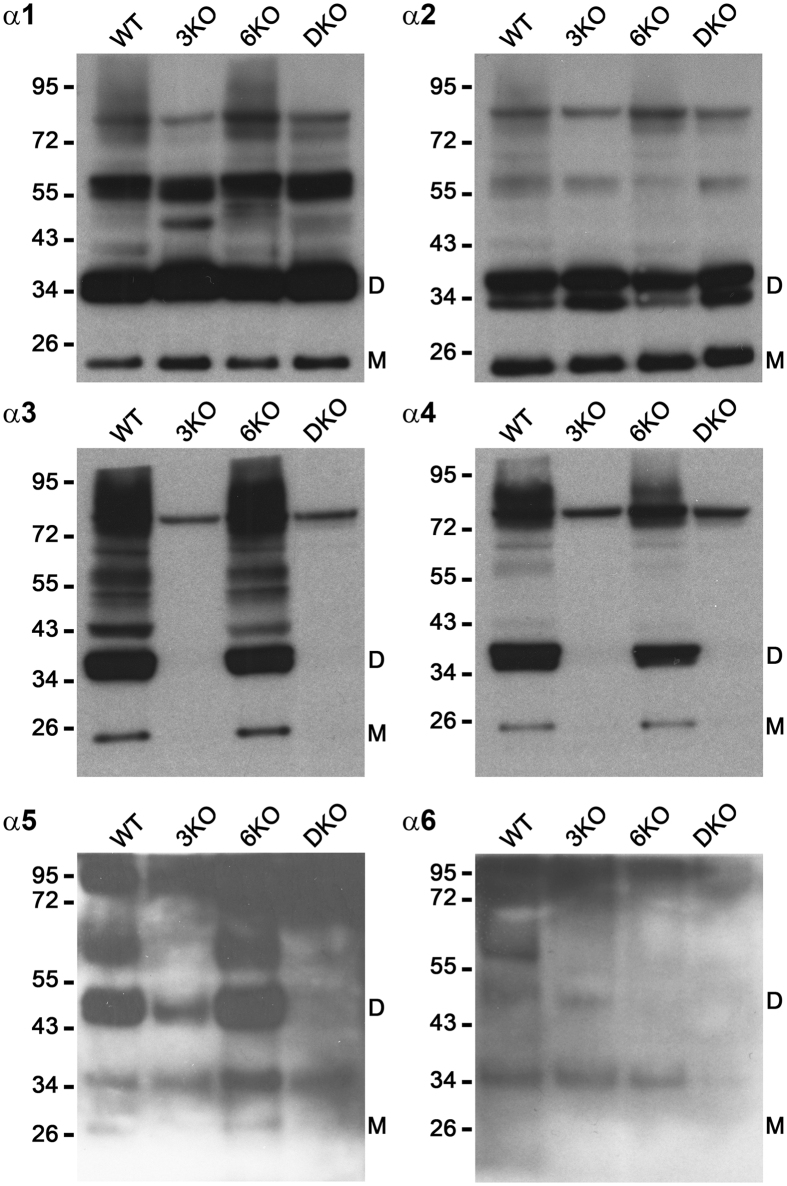
α3 (IV) to α6 (IV) chains were negative in the total kidney lysate of DKO mice.Type IV collagen α1 and α2 chains were detected as a monomer and a dimer, respectively, in all 4 groups, although type IV collagen α3 and α4 chains were only detected in wild mice (WT) and Col4a6 −/− mice (6KO) at 11 weeks of age. The dimer of the α5 (IV) chains was detected in the WT and 6KO mice and weakly detected in the Col4a3 −/− mice (3KO) but undetectable in the Col4a3 & 6 −/− mice (DKO). The monomer of the α5 (IV) chains was detected in the WT and 6KO mice but undetectable in the 3KO and DKO mice. The dimer of the α6 (IV) chains was weakly detected in the WT and 3KO mice but undetectable in the 6KO and DKO mice. D, noncollagenous domain 1 (NC1) dimer; M, NC1 monomer.